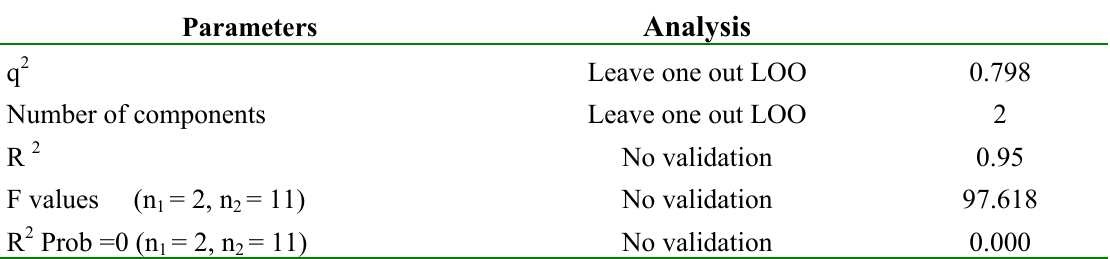
Table 8. Statistical parameters of the CoMFA model of ketone reduction by the selected microorganisms.